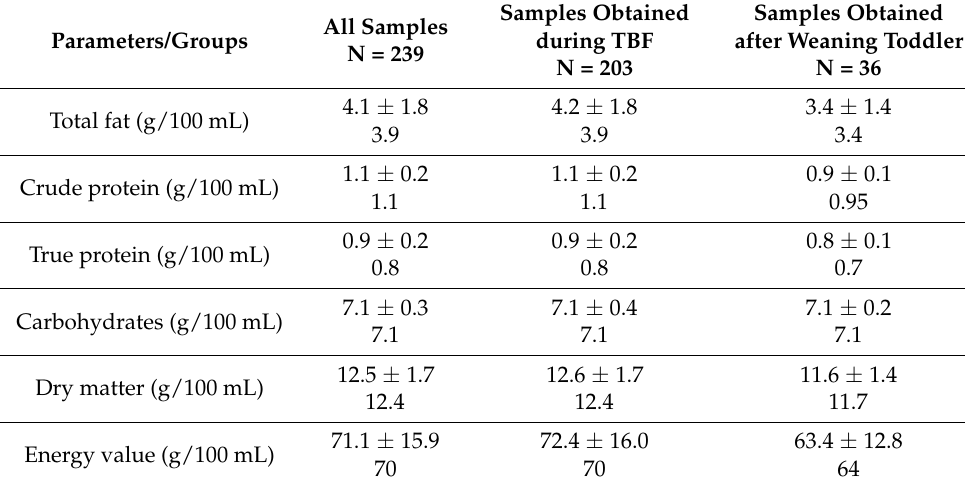
Table 2. Macronutrient and energy contents of tandem breastfeeding mothers milk and in milk samples after weaning older